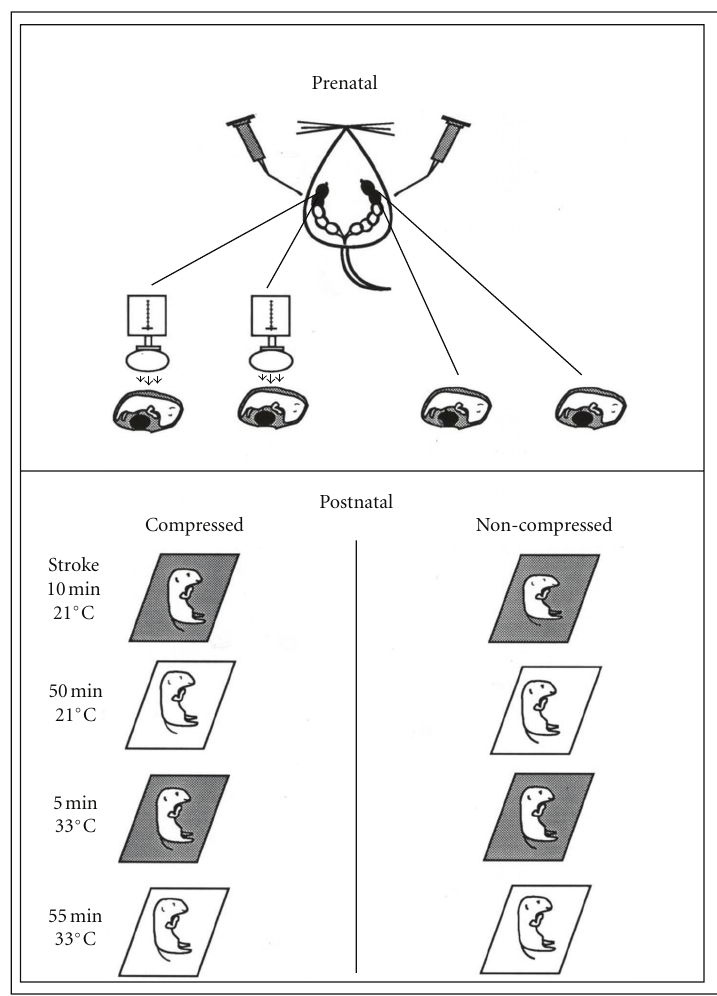
Figure 4: Sequence of perinatal manipulations prior to tests of respiration and nipple attachment. The top portion of the figure depicts injections of citral or saline into individual amniotic sacs, which was followed by compressions or no compressions (control). Pups were then delivered by caesarian section. Over the next two hours, individual pups were treated with thermal and odor regimes designed to mimic early postnatal events, shown in the lower sections of the figure. For some pups, citral was present prenatally and postnatally. Saline was used on the gauze pads of the control pups (see text). The grey and white areas around each pup depict the olfactory treatment (citral or saline control) of the moistened